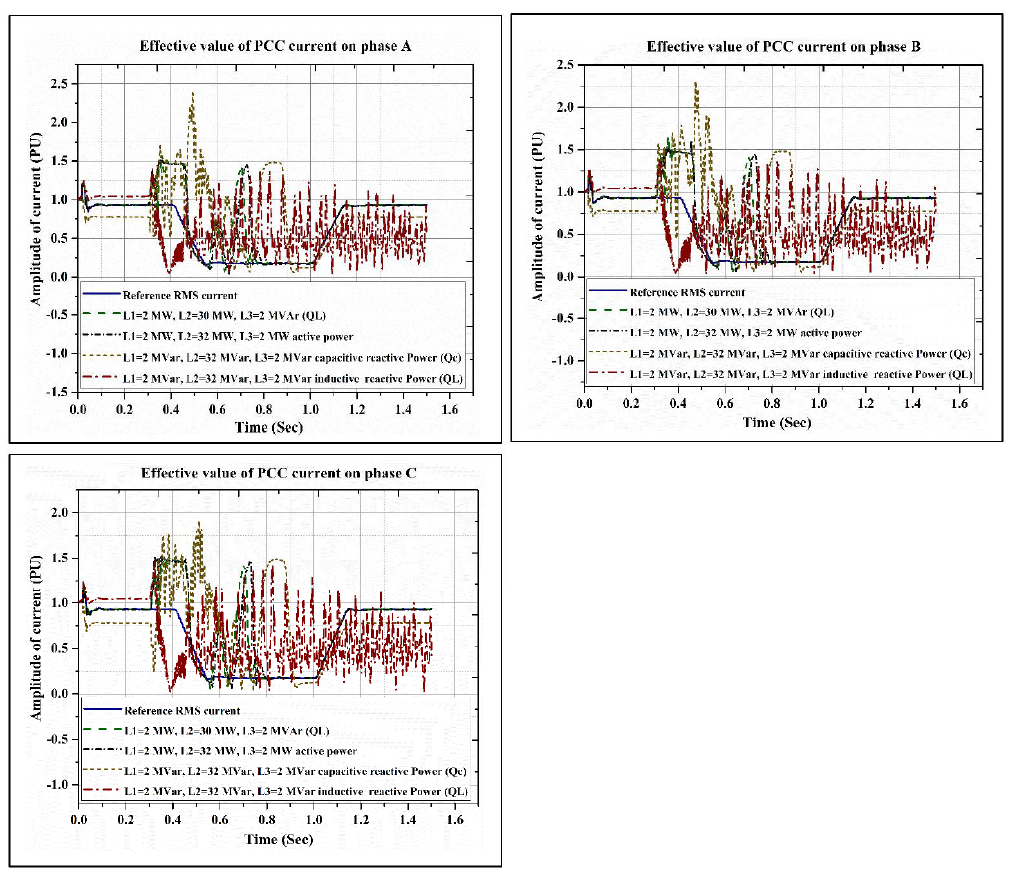
Figure 15. The effective value of PCC voltage when local loads are greater than local generation.